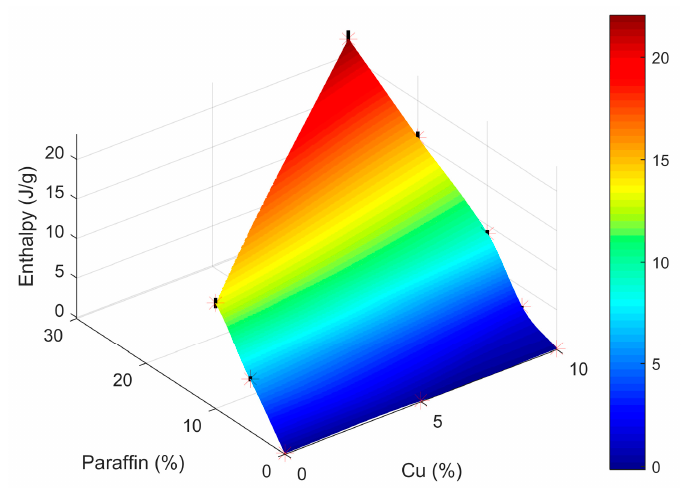
Figure 9. Enthalpy (J/g, vertical axis) for different composites (wt % Cu and wt % paraffin PCM on bottom plane axis).